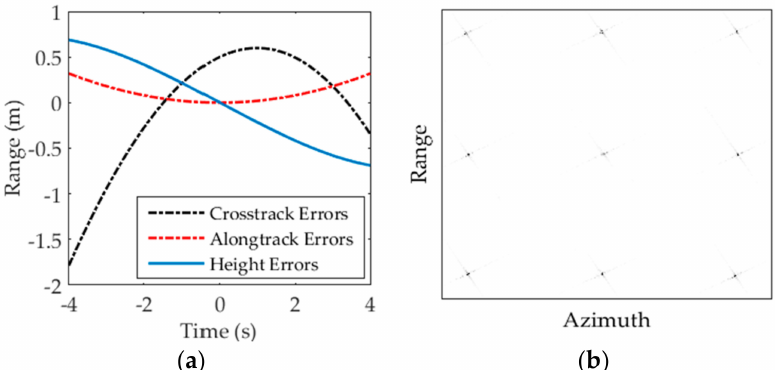
Figure 9. Motion errors and simulation results: ( a ) motion errors extracted from the airborne inertial navigation system; ( b ) focused result of the simulation spot matrix by the proposed